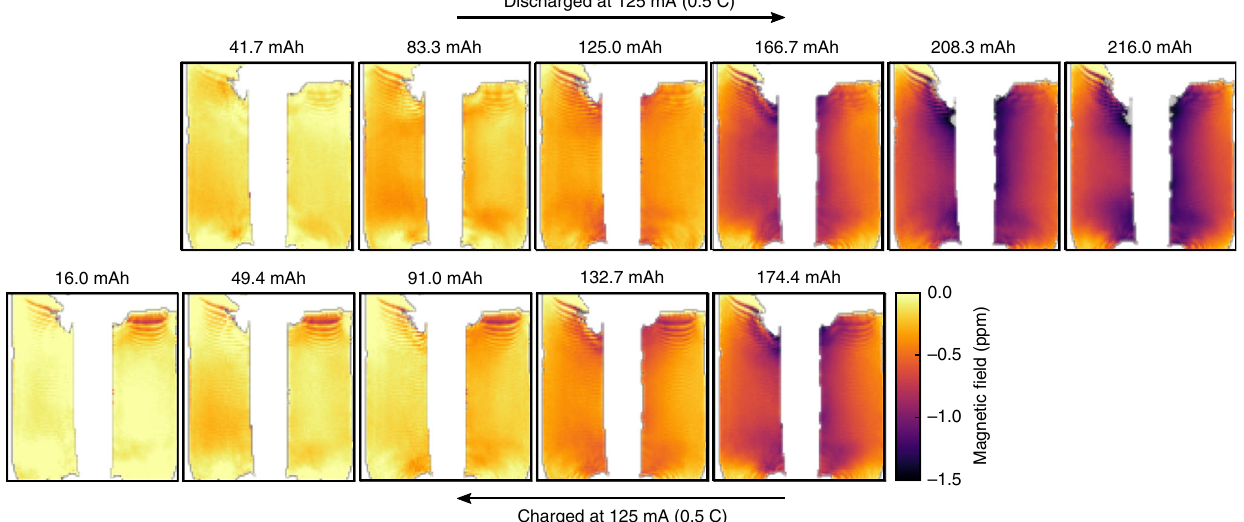
Fig. 2 Series of magnetic fi eld maps taken at intervals during discharge and then charge of the cell. The plots are labeled by the discharge capacity of the cell at each step. The magnetic fi eld maps are referenced to the fi eld map produced by the fully charged cell. The RIT cell was used for this purpose, and the susceptibility increased upon